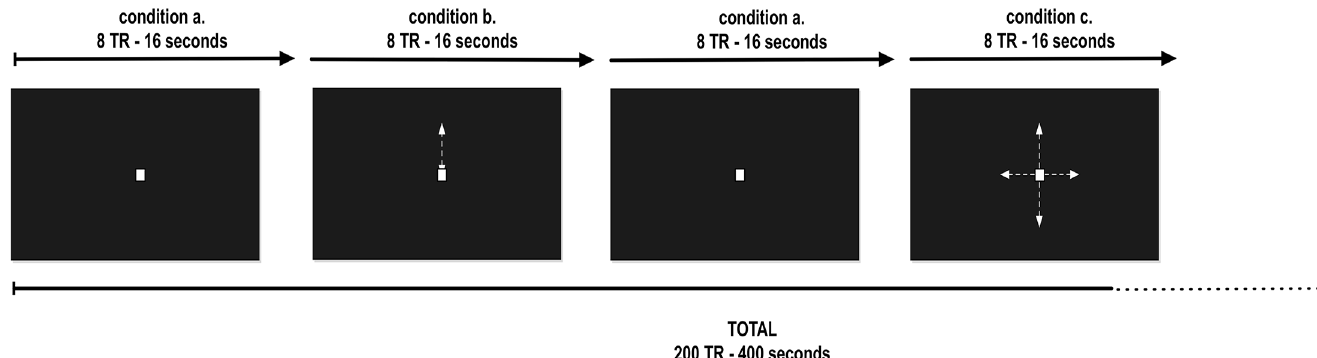
Fig 1. Functional localizer used to define the hMT+/V5 ROI. (A) Stationary dot, static condition used as baseline to the moving conditions depicted in (B) and (C). The arrows are here merely representing the dot motions used during the localizer. Each movement condition was repeated six times and randomly interleaved with the stationary dot condition. The duration of each block was 8